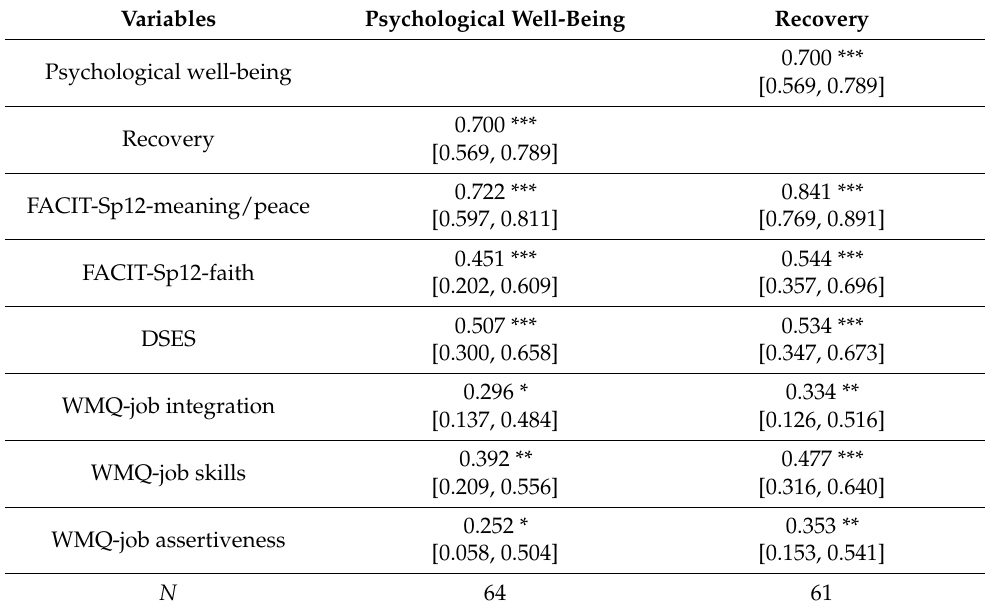
Table 2. Correlations between the studied variables. Variables Psychological Well-Being Recovery Psychological